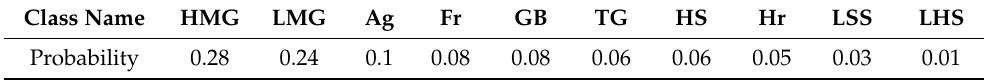
Table 3. A priori probability estimation of the vegetation classes. The probability of occurrence of each vegetation type in the study area is presented. HMG: High Matted Grass, LMG: Low Matted Grass, Ag: Agriculture, Fr: Forest, GB: Green Beach, TG: Tussock, HS: High Shrub, Hr: Herbs, LSS: Low Salix Scrub, and LHS: Low Hippopahe Shrub .